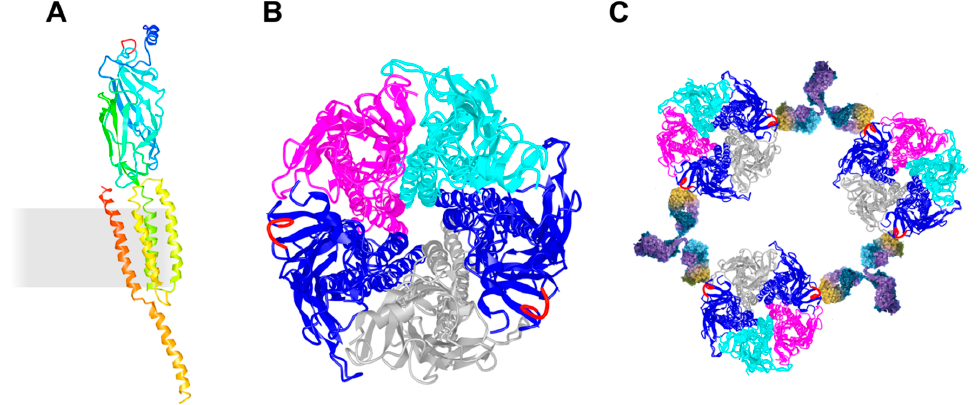
Figure 1. Schematic presentation of the AChR and its cross-linking via the MIR. ( A ) Ribbon diagram of a single AChR α subunit viewed in an orientation such that the central axis of the pentamer is to the side (right). The membrane is indicated as a grey rectangle. α -helices M1–M4 are membrane-spanning and form the ion-permeable gate of the AChR. The MIR (shown in red) is located between β 2- and β 3-strands. ( B ) Ribbon diagram of the whole receptor viewed from the synaptic cleft. AChR α in blue with the MIR in red, AChR β in magenta, AChR δ in cyan, and AChR γ in grey. The MIR is shown in red. ( C ) Schematic presentation of autoantibody-induced inter-molecular cross-linking via the MIR. The molecular models were drawn using the molecular coordinates from the density maps deposited in the Protein Data Bank (PDB file accession number 3BG9 [112]) and the Web-based 3D Structure Viewer iCn3D.